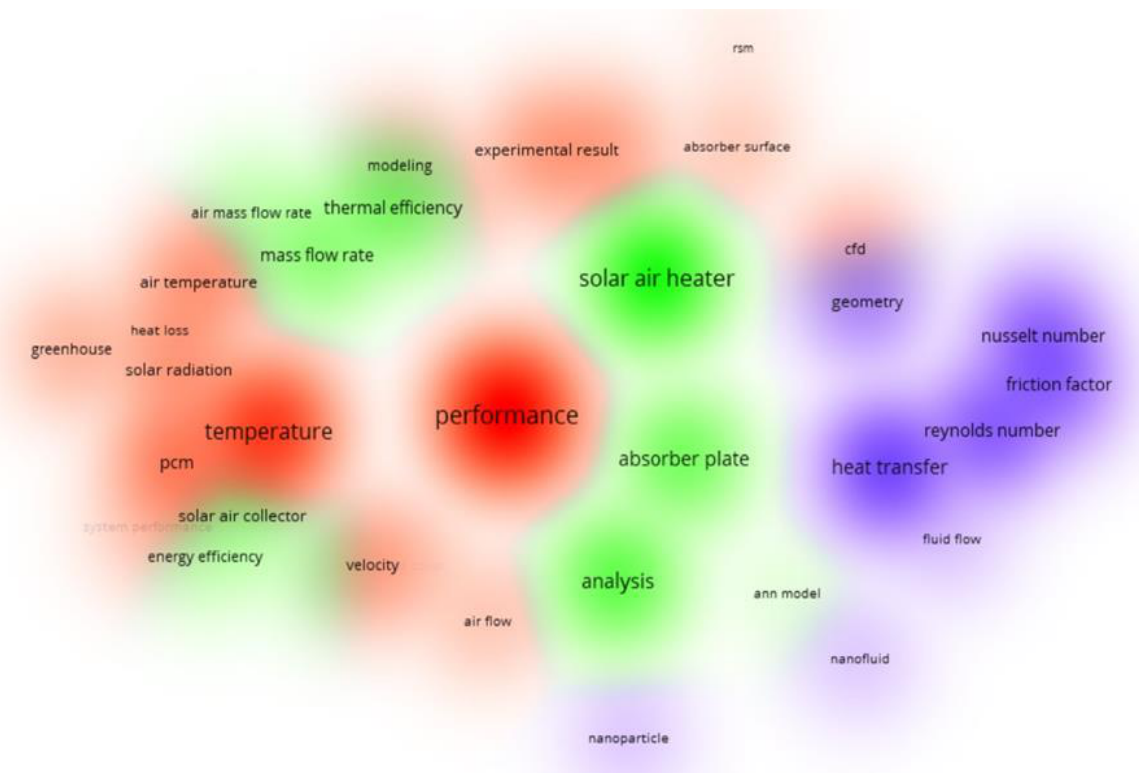
Figure 9. Solar air heaters keyword bibliometric density network.